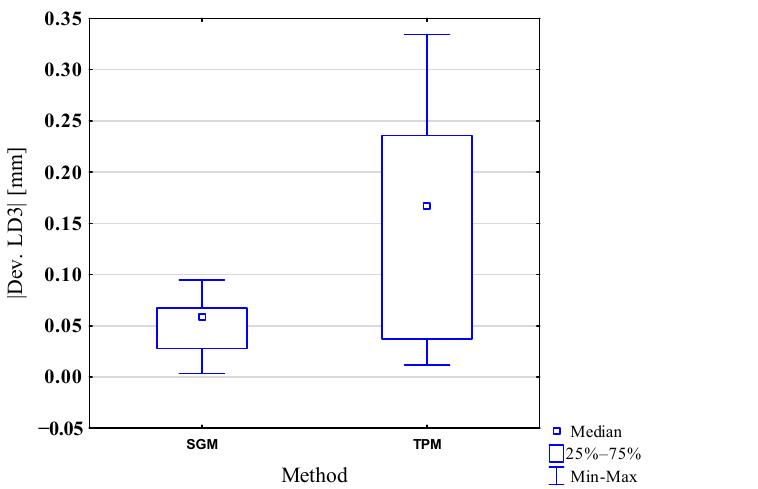
Figure 8. Comparison of the absolute values of the linear dimension 3 deviations for SGM and TPM methods.